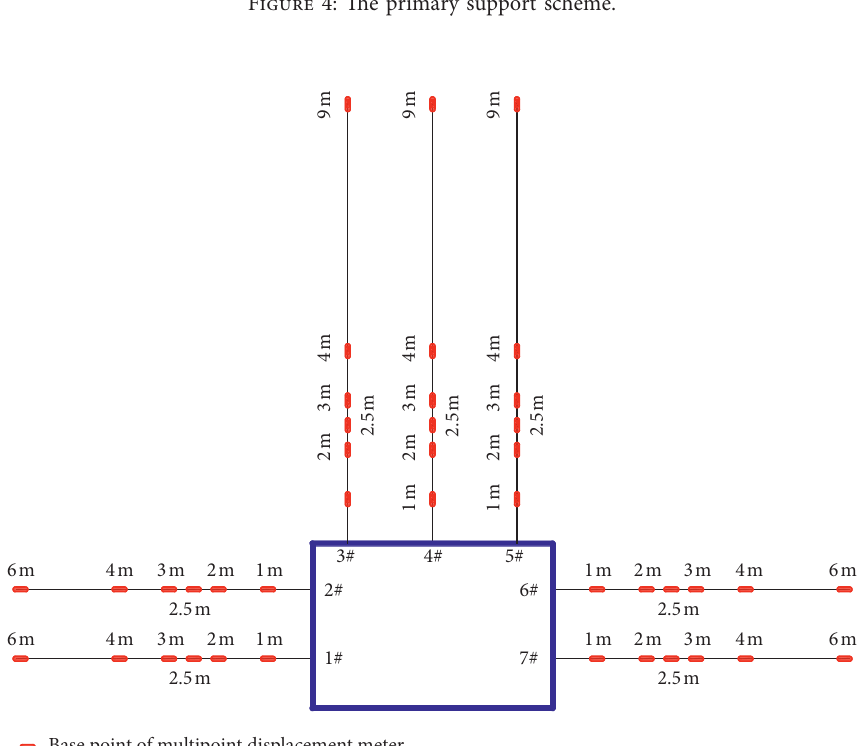
Figure 5: Borehole imaging tool locations and displacement meter